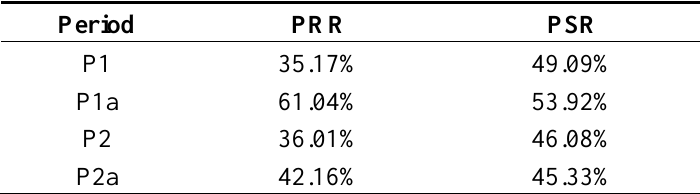
Table 5. Network-level performance metrics for the two XMesh evaluation periods and their respective sub-periods, including packet reception rate (PRR) and packet success rate